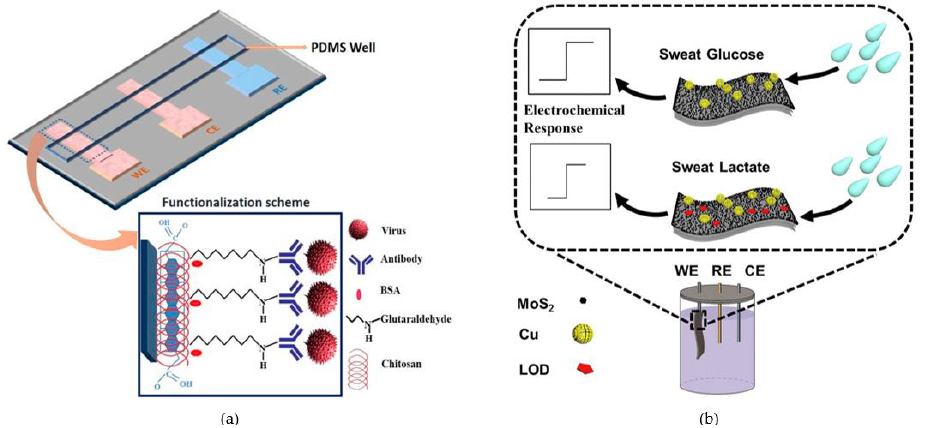
Figure 5. ( a ) The paper-based immunosensor with a PDMS well; ( b ) Graphene paper-based platform for sweat glucose and lactate sensing. ( a ) Reproduced with permission. Ref. [181] Copyright 2017, Sensors (Basel). ( b ) Reproduced with permission. Ref. [189] Copyright 2018, Anal